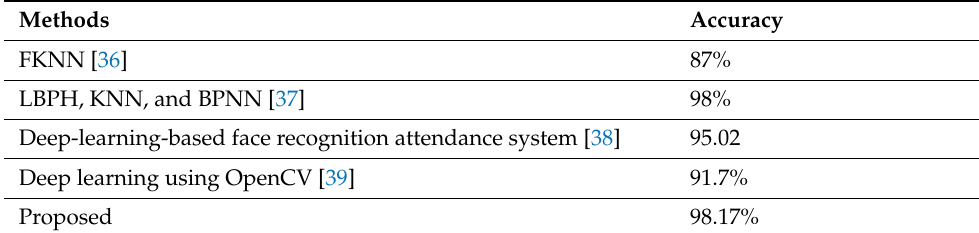
Table 4. Comparison between the proposed and other deep learning